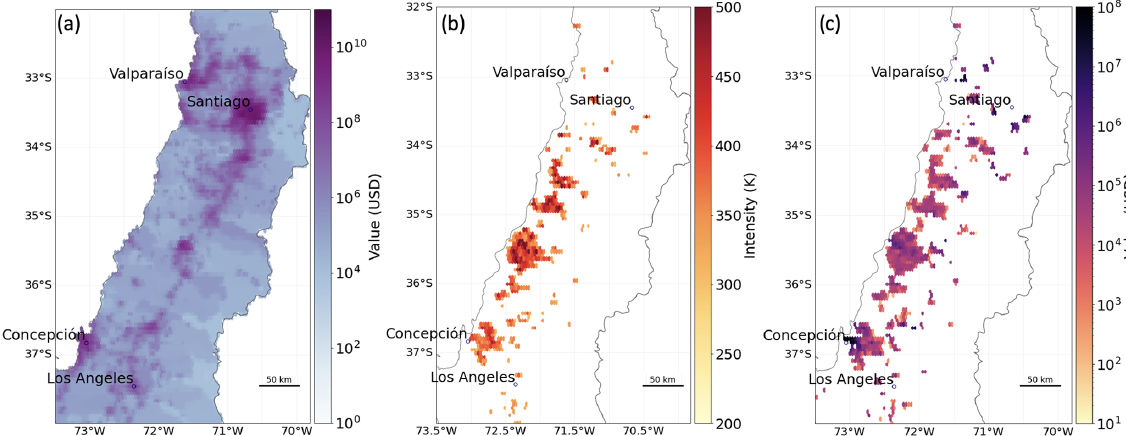
Figure 3. Maps of Chile showing (a) the spatial distribution of asset exposure value generated using LitPop, (b) the wildfires active in January 2017, and (c) the resulting damage per grid point as estimated by